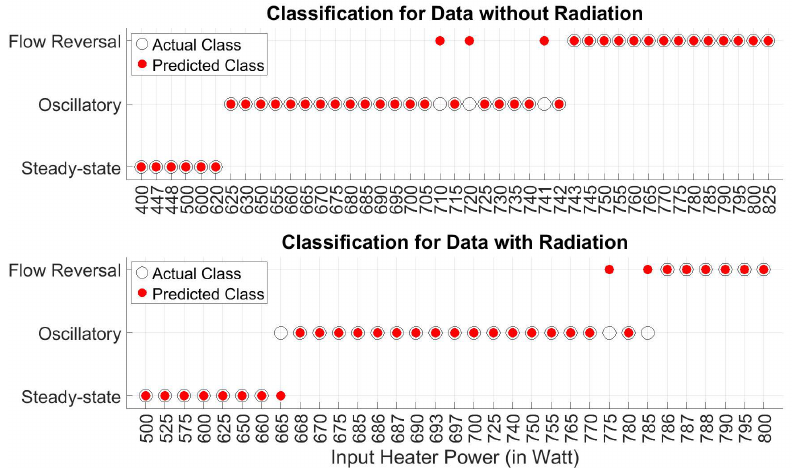
Figure 4. Case-wise classification accuracy for both datasets (without and with radiation) for PFSA.